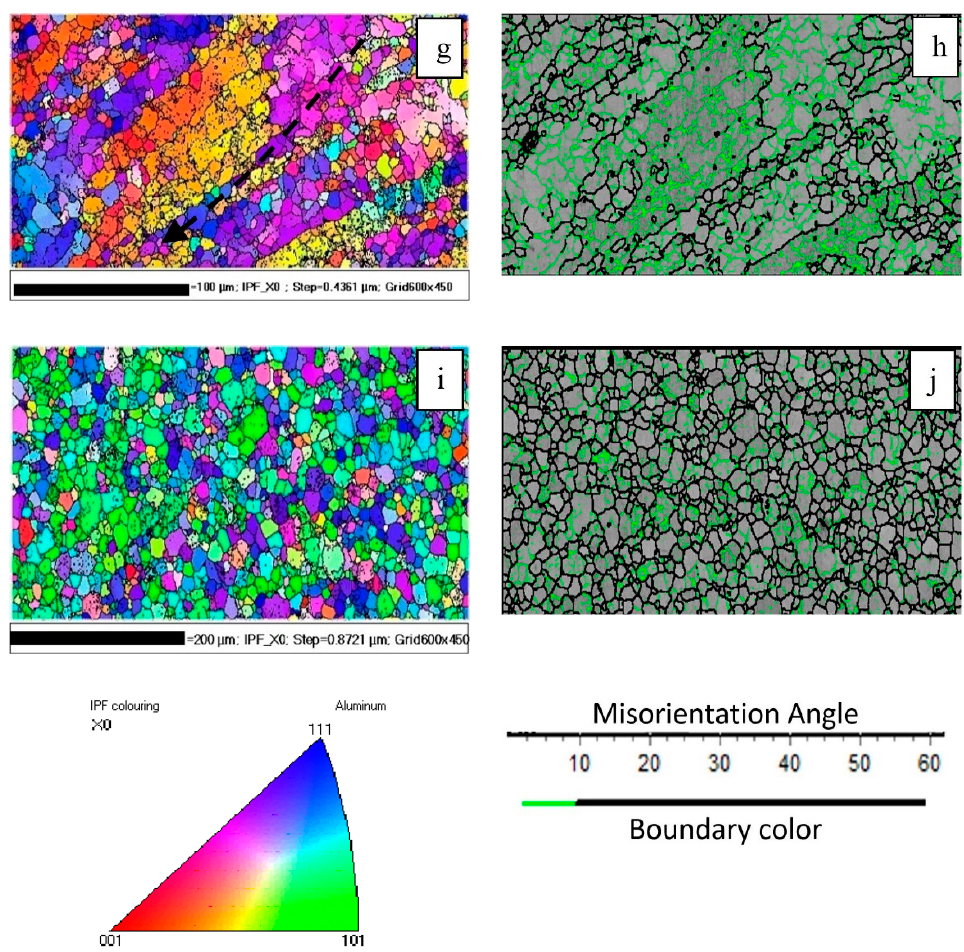
Figure 6. IPF-X maps of different areas of the weld. BM: ( a , b ); onion rings (area I): ( c , d ); weld center (area II): ( e , f ); weld center (area III): ( g , h ); RS (area IV): ( i , j ).